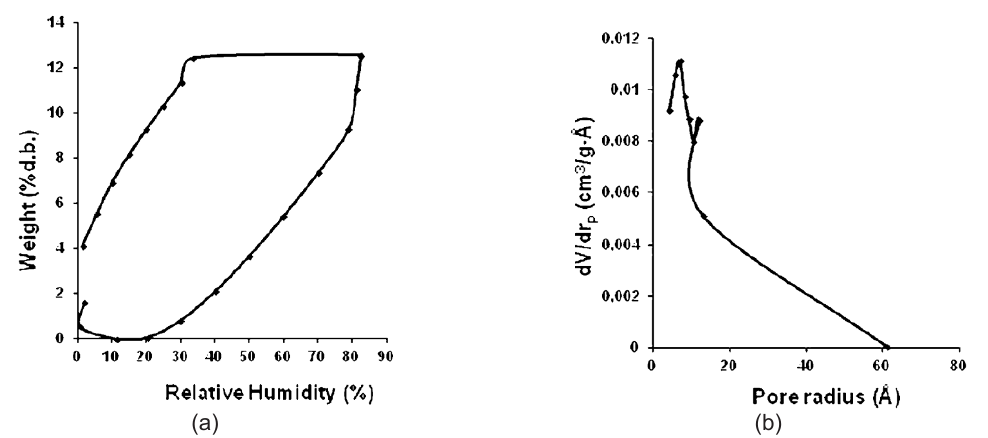
Figure 2. Water adsorption-desorption isotherm (a) and pore size distribution curve (b) of the synthesized